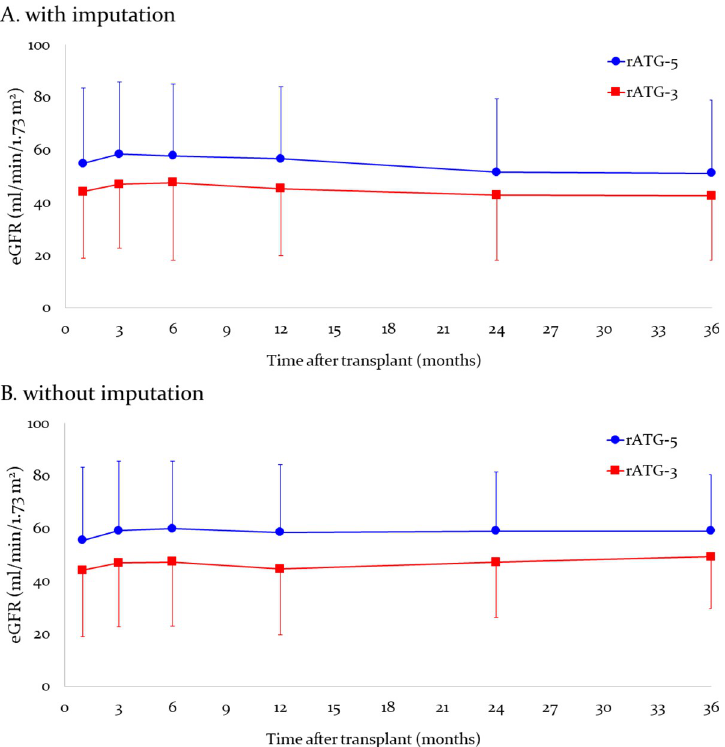
Fig 3. Renal function trajectories (eGFR) over the first three years after kidney retransplantation, comparing patients receiving 5 and 3 mg/kg rATG induction therapy. Data represents mean and standard deviation of eGFR with imputation (zero value for patients with graft loss, and last observation carried forward for patients who died or were loss to follow up).